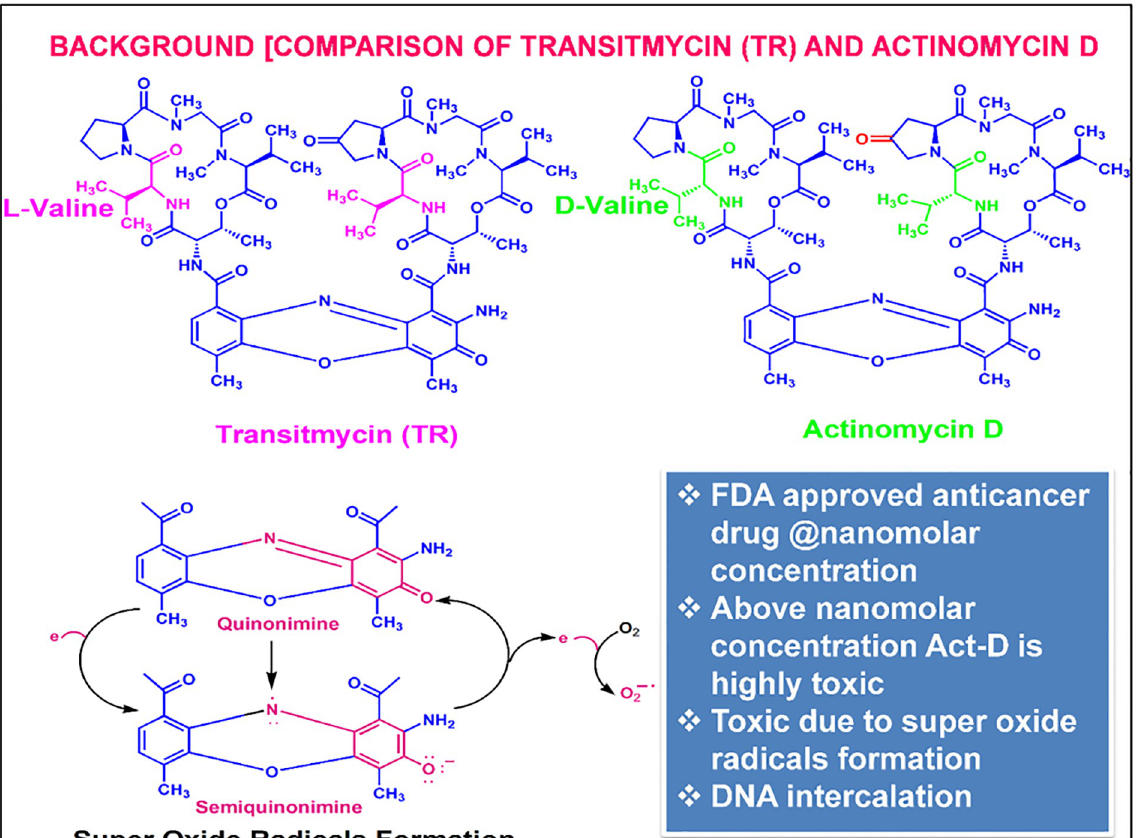
Fig 1. Structural comparison between TR and